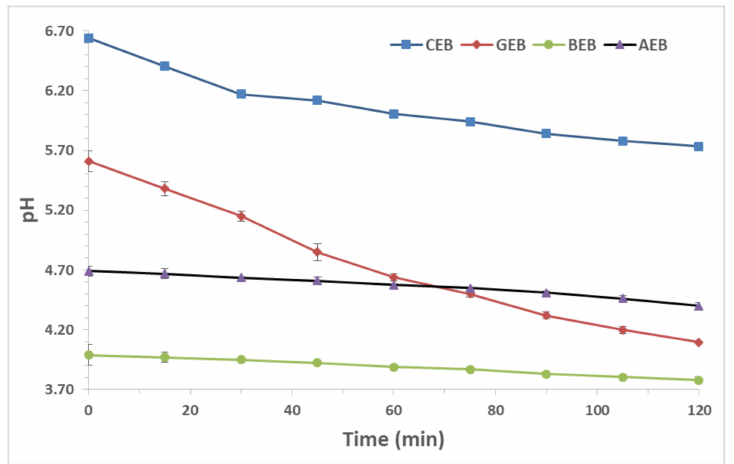
Figure 2. Acidification kinetics during beverage fermentation. (CEB: Control Emmer Beverage; GEB: Emmer Beverage with Grape juice; BEB: Emmer Beverage with Blueberry juice; AEB: Emmer Beverage with Aronia